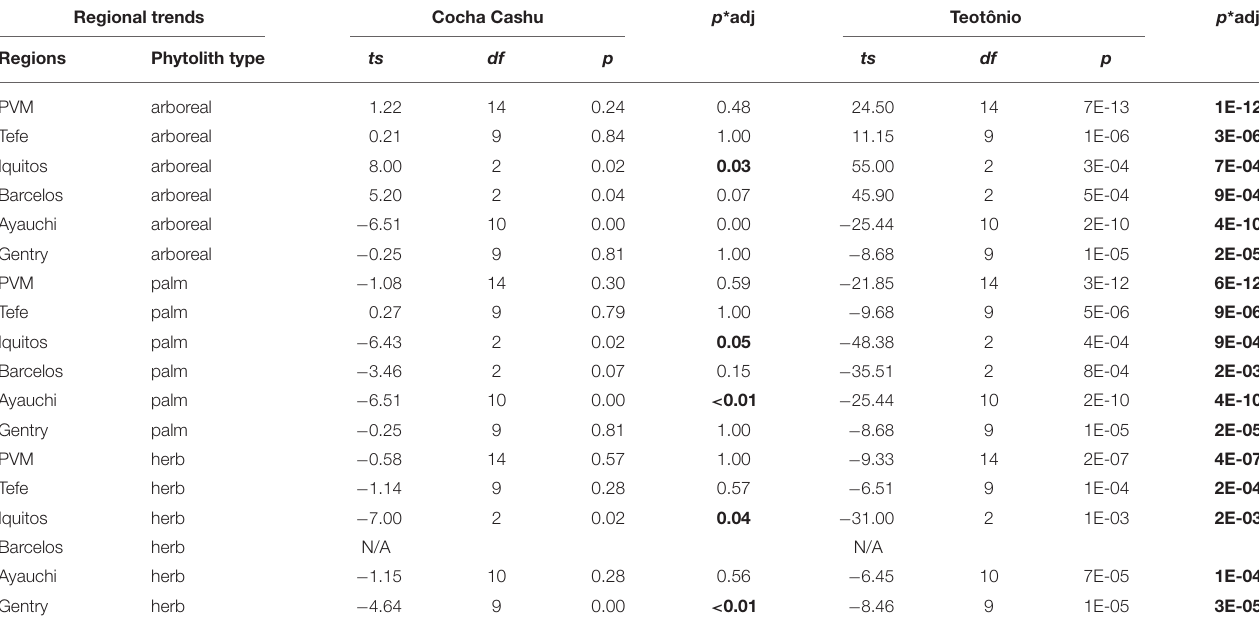
TABLE 2 | One-sample t -test results from regional comparisons of trend values (trend = surface–basal) of arboreal, herb and palm phytoliths with values obtained at Cocha Cashu and Teotônio. Regional